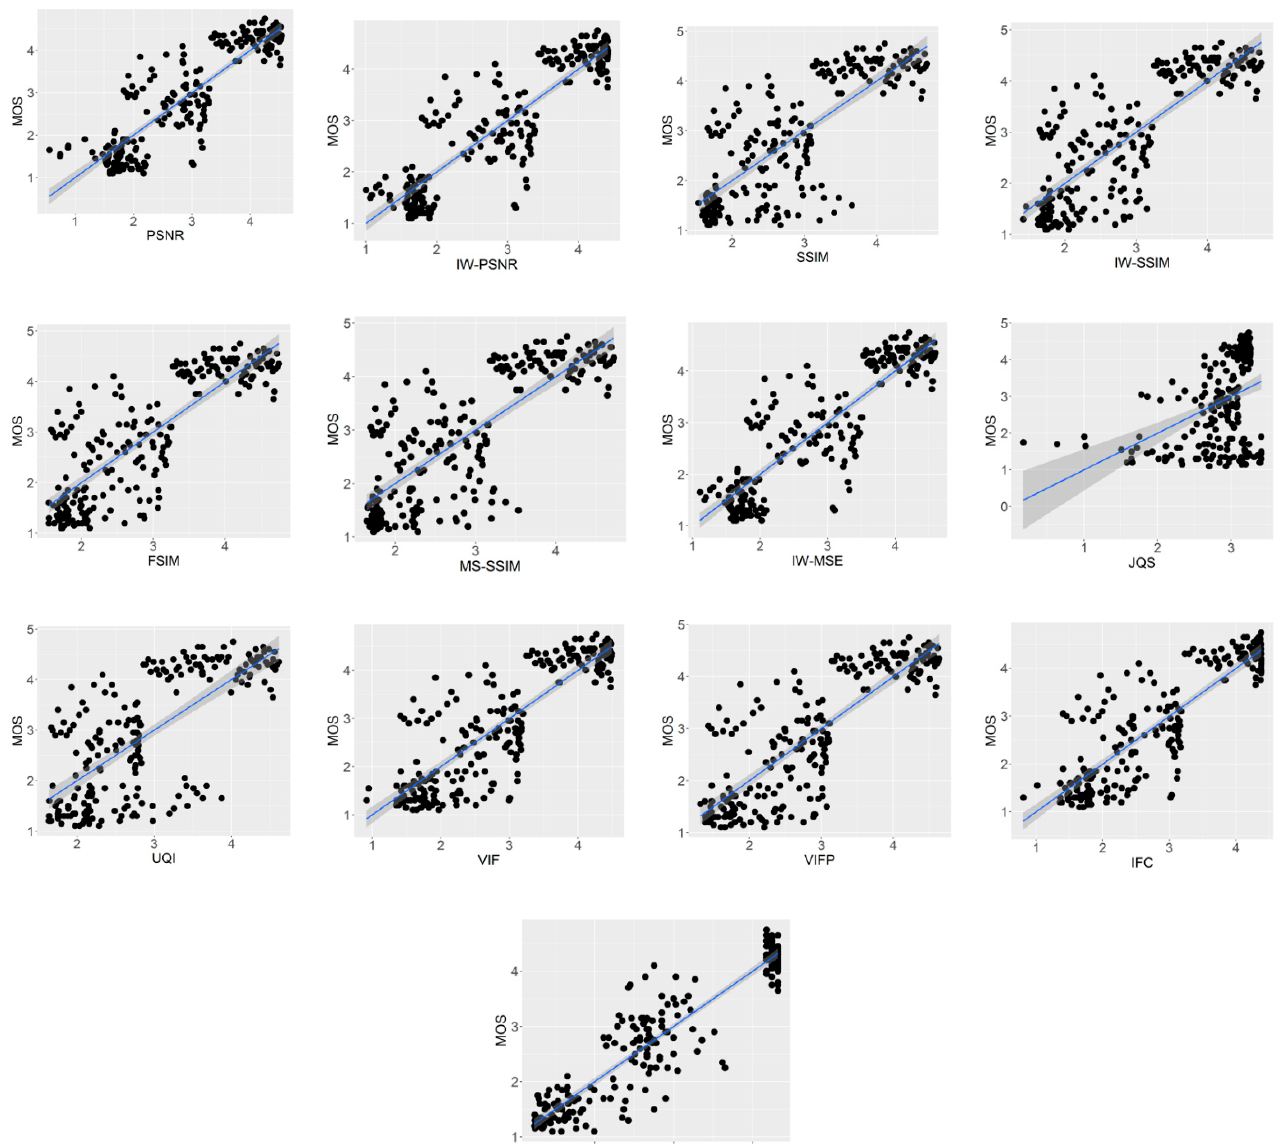
Figure 8. Scatter plots of all compared objective metrics on the LF dataset. The black dots in the scatter plots represent a paired measurement of two variables (i.e., Objective quality metric and MOS), while the blue lines are the fitted linear function on the LF dataset of each objective quality metric.